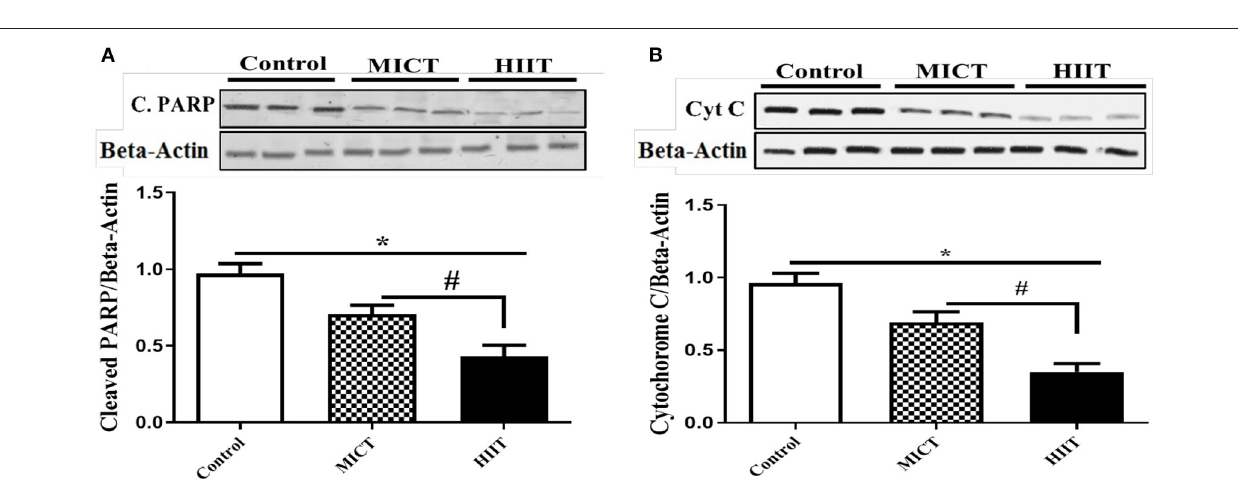
FIGURE 3 | Effects of HIIT and MICT protocol on apoptotic intermediate molecules. (A) Cleaved PARP (C.PARP). (B) Cytochrome C. Data are presented as means ± standard error of the mean (SEMs). *Significant differences between control and intervention groups, # Significant differences between MICT and HIIT. MICT, moderate-intensity continuous training; HIIT, high-intensity interval training, n = 6 and rats trained for 5